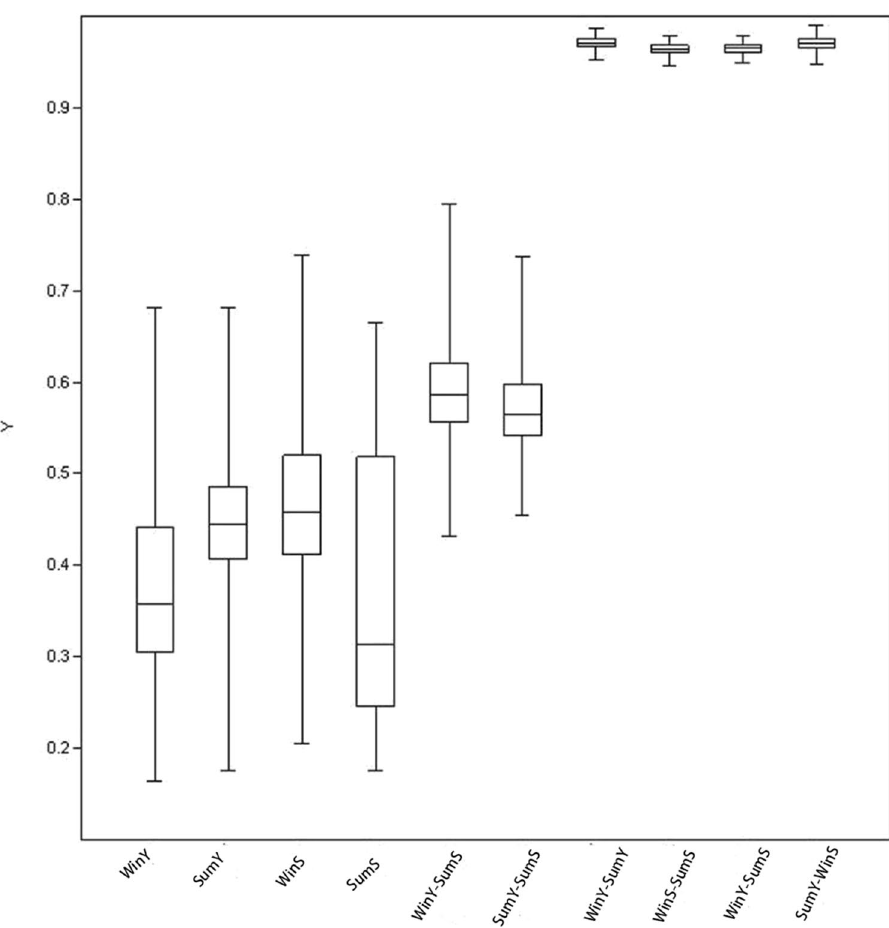
Figure 4. Beta diversity-based Bray–Curtis distances of the samples inside the groups and between the different